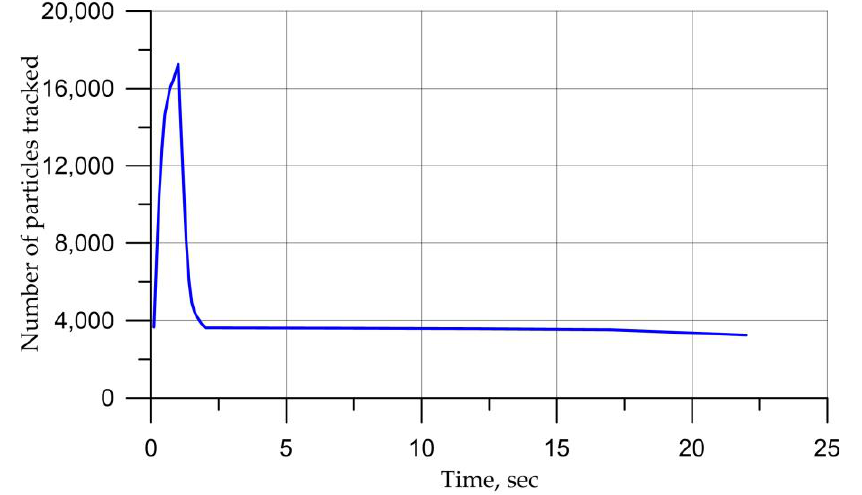
Figure 15. Particle concentration over time.